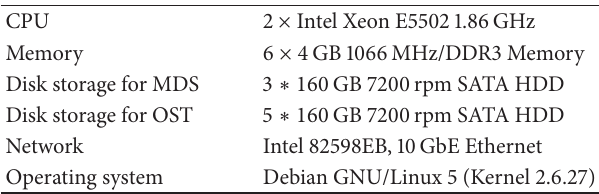
Table 1: Specification of nodes on cluster 1.